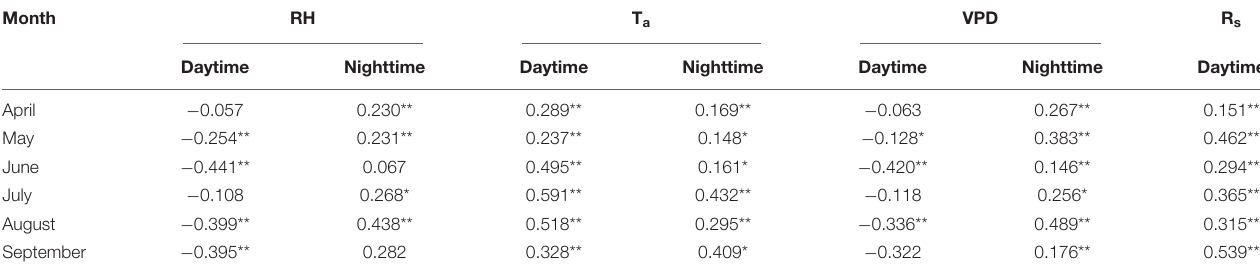
FIGURE 3 | Variations of meteorological factors by month. TABLE 2 | Partial correlation between sap flow velocity and meteorological factors for each